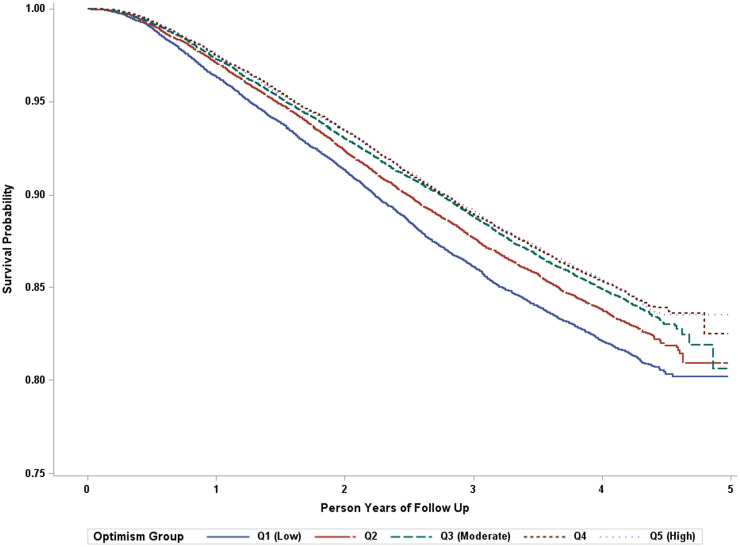
Unadjusted Kaplan–Meier survival curve for optimism and incident hypertension. Estimated survival probability of incident hypertension according to the level of optimism, with individuals with higher optimism at lower risk of developing hypertension.